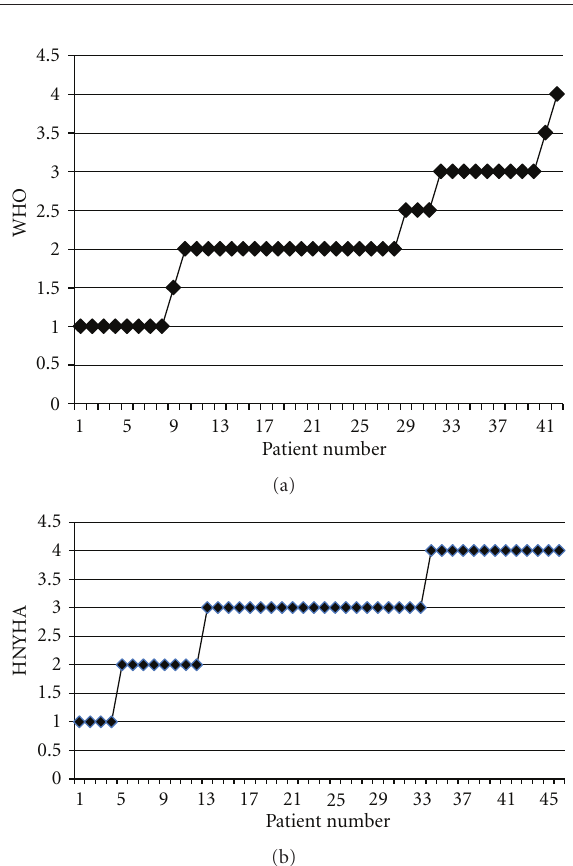
Figure 2: WHO classification for PH group and NYHA classifica- tion for HF